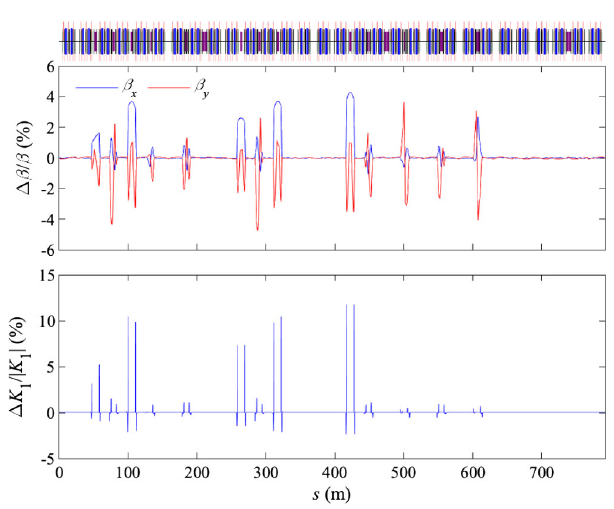
FIG. 3. Locally compensated distortion of β